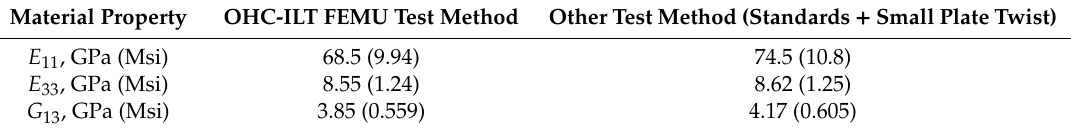
Table 4. Comparison of average constitutive properties obtained using the OHC-ILT test with other test methods for the fabric